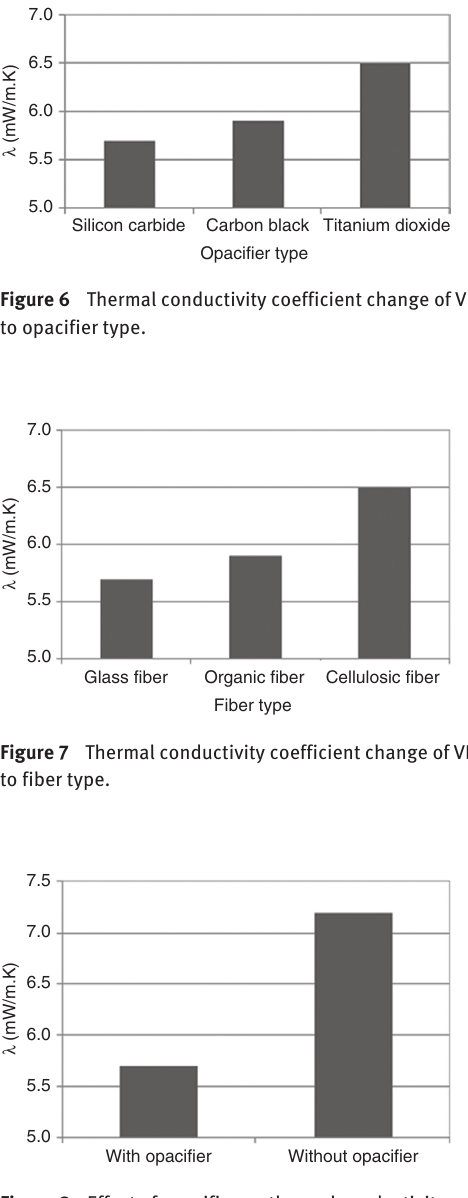
Figure 8 Effect of opacifier on thermal conductivity coefficient on VIP